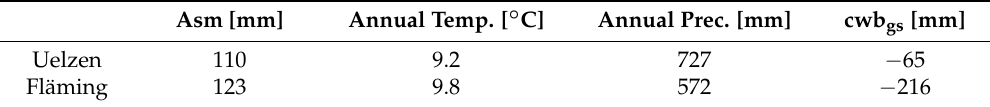
Table 2. Site characteristics in Uelzen and Fläming (climate values as averages in the period 1991 to 2010; asm: available soil moisture calculated for 1 m soil depth, annual temp.: annual mean temperature; annual prec.: total annual precipitation; cwb gs : climatic water balance (=precipitation − evapotranspiration for grass) in growing season).